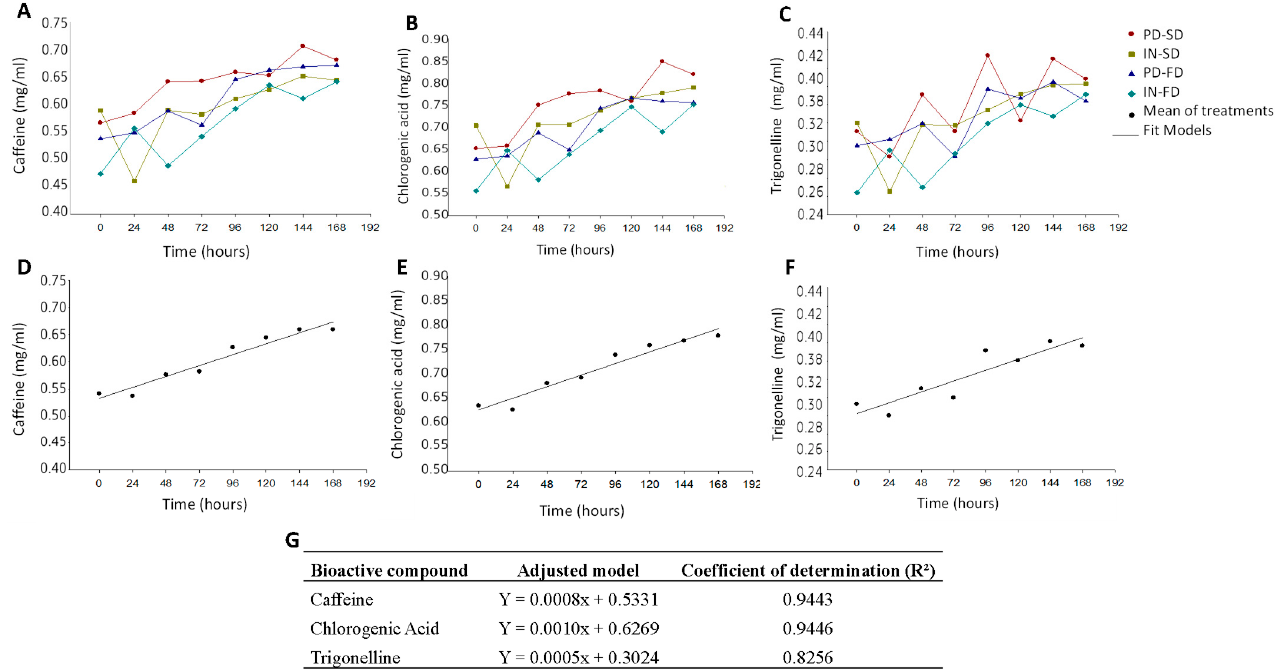
Figure 2. Content of caffeine, chlorogenic acid, and trigonelline during storage in dairy beverages incorporated with encapsulated extracts of green coffee. ( A ) Dispersion of the caffeine content in each beverage incorporated; ( B ) dispersion of the chlorogenic acid content in each beverage incorporated; ( C ) dispersion of trigonelline content in each beverage incorporated; ( D ) general behavior of caffeine for all beverages; ( E ) general behavior of chlorogenic acid for all beverages; ( F ) general behavior of trigonelline for all beverages; ( G ) models fitted for caffeine, chlorogenic acid, and trigonelline. PD-SD: beverage added from the extract encapsulated with polydextrose by spray-dryer; IN-SD: beverage added from the extract encapsulated with inulin by spray-dryer; PD-FD: beverage added from the extract encapsulated with polydextrose by freeze-drying; IN-FD: beverage added from the extract encapsulated with inulin by freeze-drying.